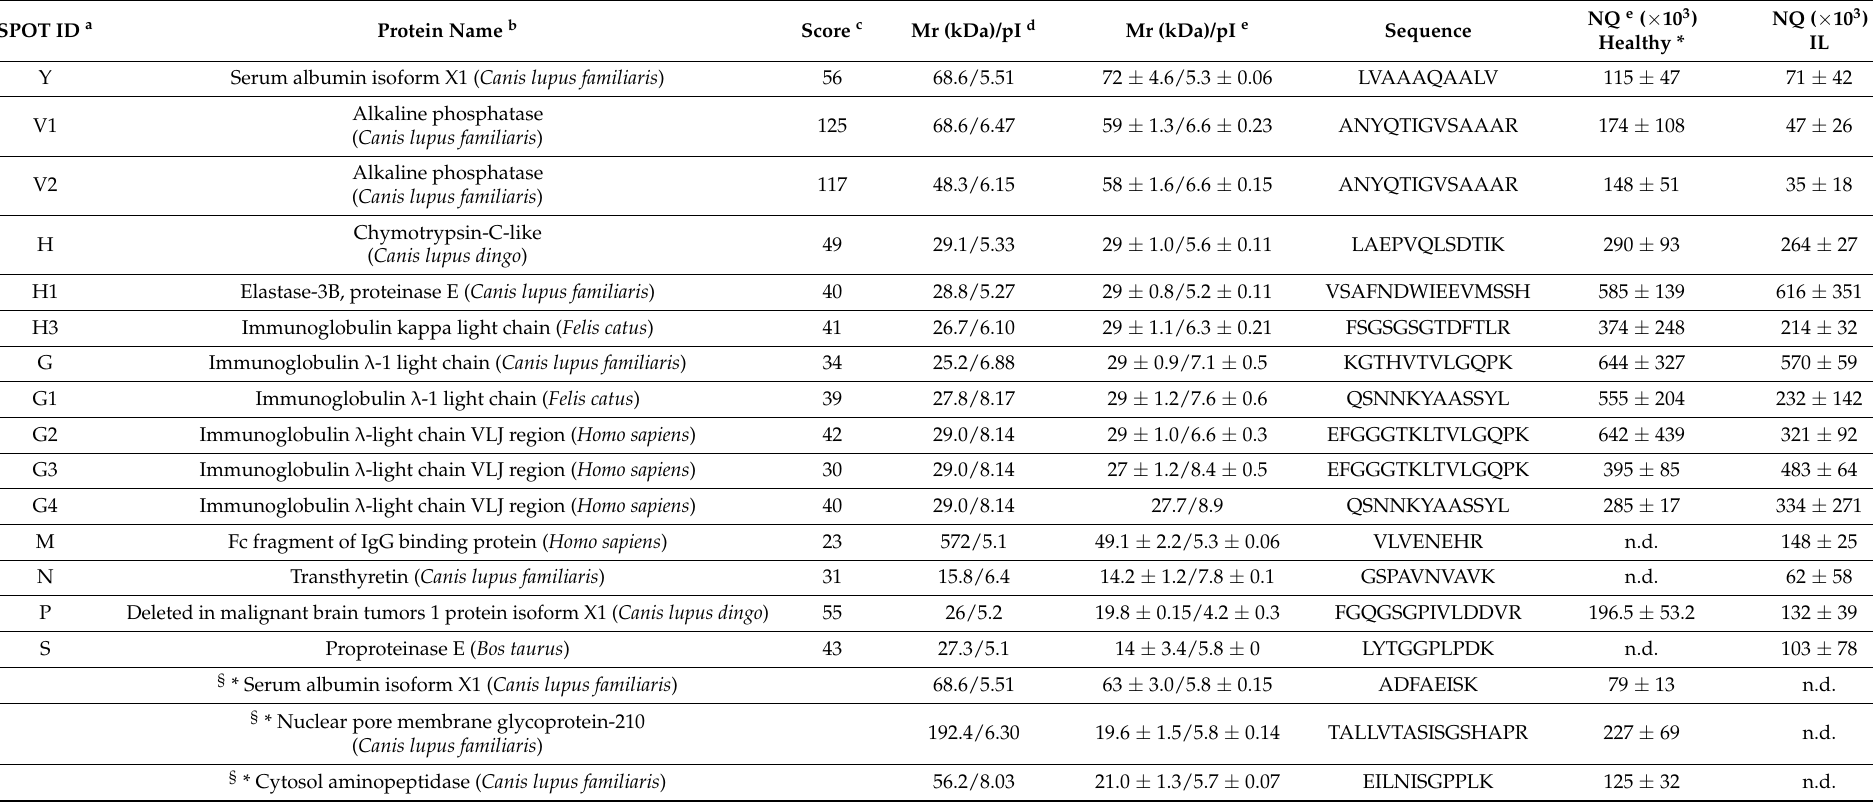
NQ: normalized quantity. n.d.: not detected. a Assigned spot ID as indicated in Figure 1. b MASCOT results (SwissProt and NCBInr databases). c MASCOT score reported. d From SwissProt and NCBInr databases. e Experimental values were calculated from the 2DE maps by the PDQuest software ( ± standard deviation). * Normalized quantities from healthy subjects were obtained from a previous study from the same research group [23]; § spots absent in IL but present in clinically healthy